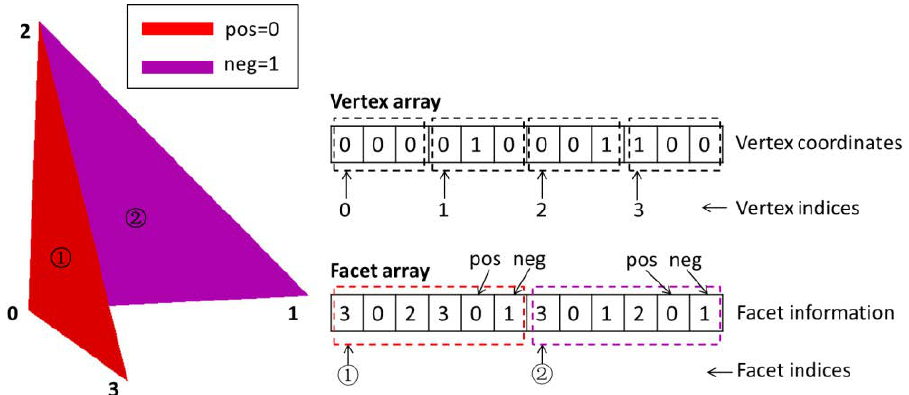
Figure 3. An example of a simple multi-labeled mesh represented by 2 arrays (vertex array and facet array). The vertex array stores the vertex indices and vertex coordinates. The facet array stores the facet information and the corresponding labels. Each facet is composed of the number of vertexes and the indices of vertexes. For example, facet ① is composed of 3 vertexes (the vertex indices are 0, 2 and 3); Facet ② is composed of 3 vertexes (the vertex indices are 0, 1 and 2). The input mesh M i without labels is added the pos and neg labels according to the interior and exterior directions of the model to form a single-labeled mesh SM i . The input l meshes are assigned a label i ( i = 1, 2, . . . , l ) , respectively, corresponding to the material in turn. The zero label represents exterior boundary of the mesh model. In addition, to distinguish the materials corresponding to interior and exterior regions of the model, the interior and exterior sides of the triangular facet 𝑡 are set to different labels. The interior region corresponding to the negative side of the triangular facet 𝑡 (the region pointed in the opposite direction to the normal direction of the triangular facet) is represented as a